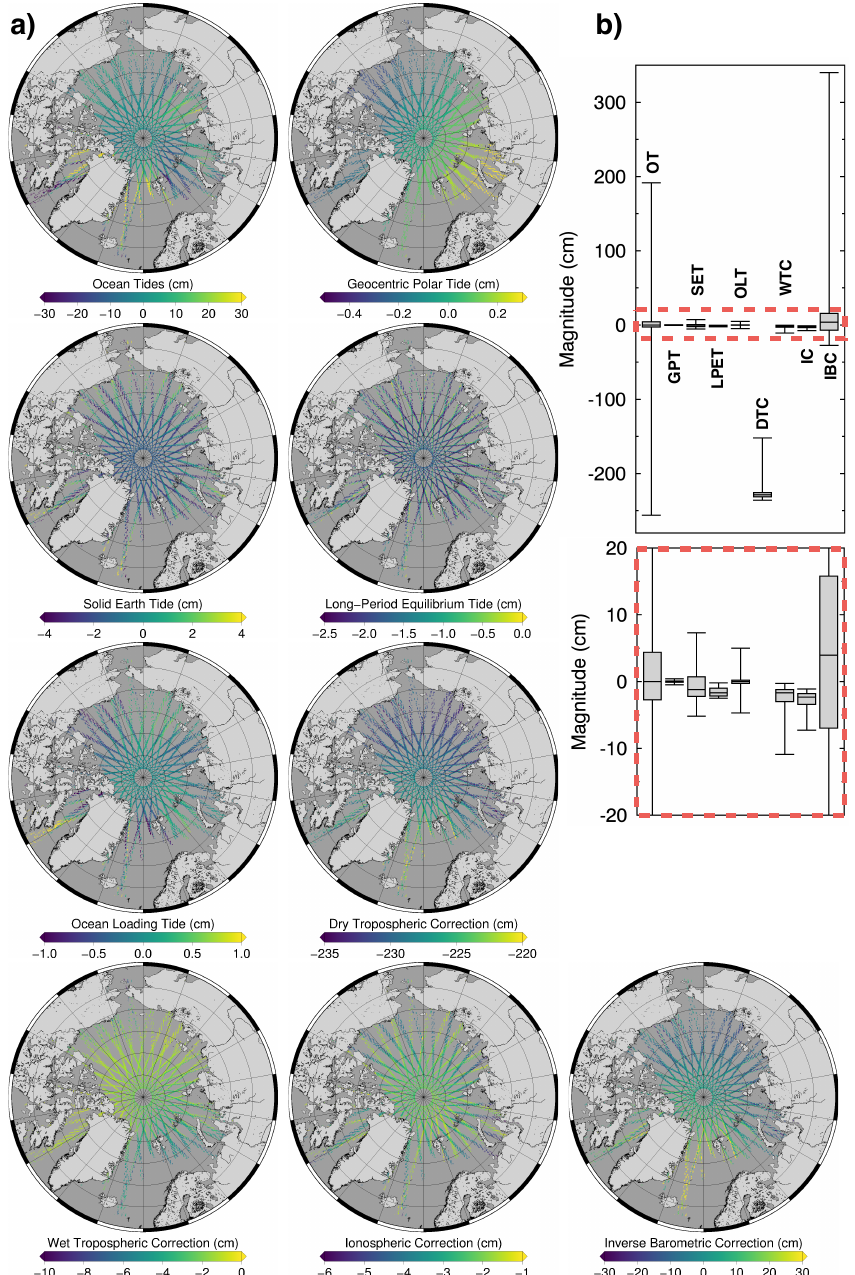
Figure 1. ( a ) The panel shows the ranges and patterns of all considered geophysical corrections. The corrections are retrieved from CryoSat-2 Level-1b orbit files of the first seven days of March 2015. The data are averaged on a 10 × 10 km grid; ( b ) The Box-plot shows minimum, lower quartile, median, upper quartile, and maximum values of each geophysical correction according to ( a ). The lower red-dashed box is an enlargement of the upper red-dashed